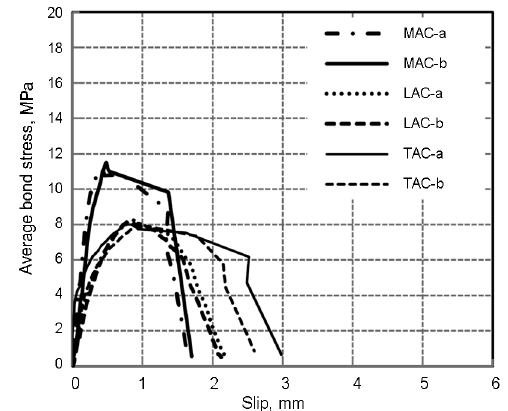
Fig. 4. Average bond stress-slip curves in specimens with CFRP bars bonded with epoxy